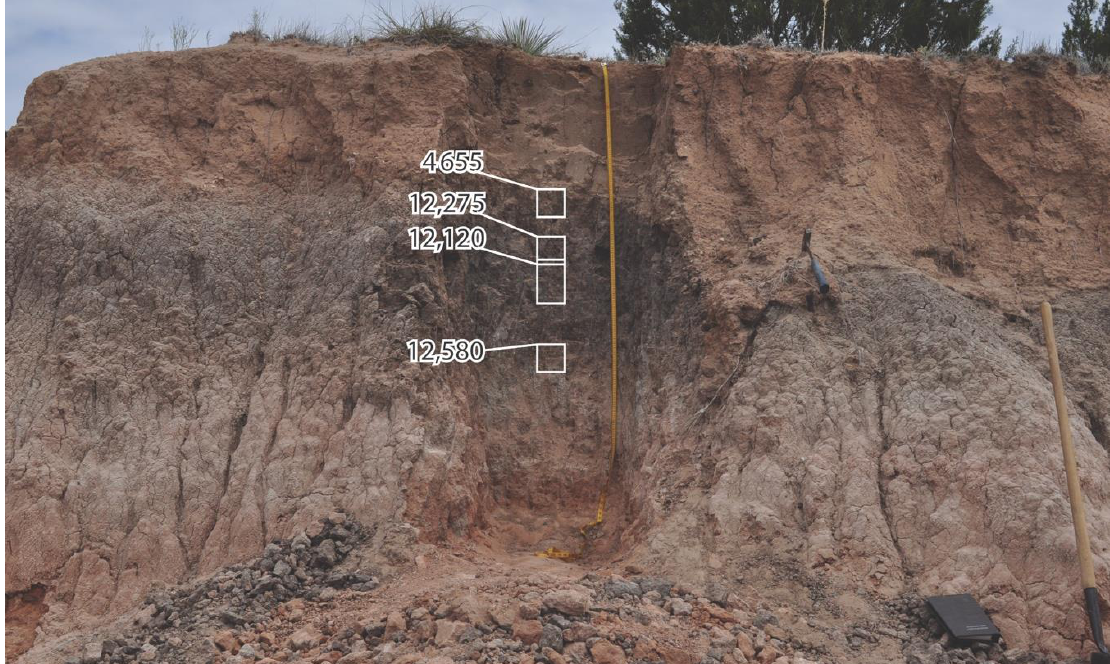
Figure 3. Late-Pleistocene- and early Holocene-age UU soil and middle-Holocene ULS soil (UU Locality 4) and accepted radiocarbon ages in a terrace remnant of the South Fork River within the eastern escarpment breaks of the Southern High Plains,